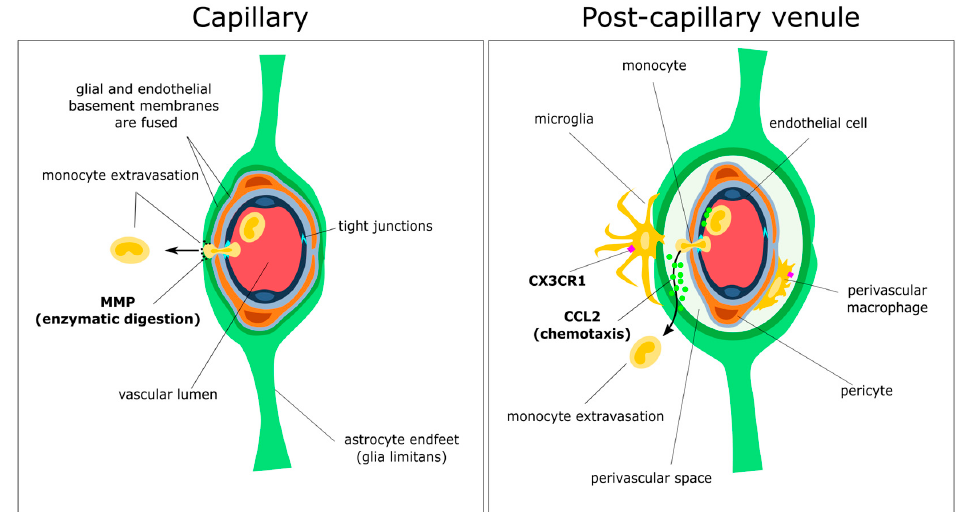
Figure 2. Simplified schematic drawing of the anatomy and function of the perivascular niche. The blood–brain barrier consists of a layer of microvascular endothelial cells connected by selective tight-junctions that prevent the passage of most large molecules and cells. These junctions rapidly remodel to allow passage of leukocytes such as monocytes through to the glial and endothelial basement membranes. An important distinguishing feature between capillaries and post-capillary venules is the separation of glial and endothelial basement membranes in the latter (right), forming the perivascular space. Also embedded in the endothelial basement membrane are pericytes, a population of mesenchymal cells responsible for maintaining endothelial cell formation and function, and polarising astrocyte endfeet. Perivascular macrophages (labelled, right) may derive from embryonic precursors, or may arise from infiltrating monocytes that have passed through the post-capillary endothelium. To reach the CNS parenchyma, cells must pass through the glia limitans, consisting of astrocyte endfeet attached to a basement membrane (arrows). This is achieved in part by coordinated chemotaxis with chemokines such as chemokine ligand 2 (CCL2; right arrow), and enzymatic digestion of intact basement membrane by matrix metalloproteinases (MMPs; left arrow). Also pictured are rare fractalkine receptor (CX3CR1)-positive parenchymal cells that appear to extend processes through the glia limitans, possibly to sample antigen from the perivascular niche.